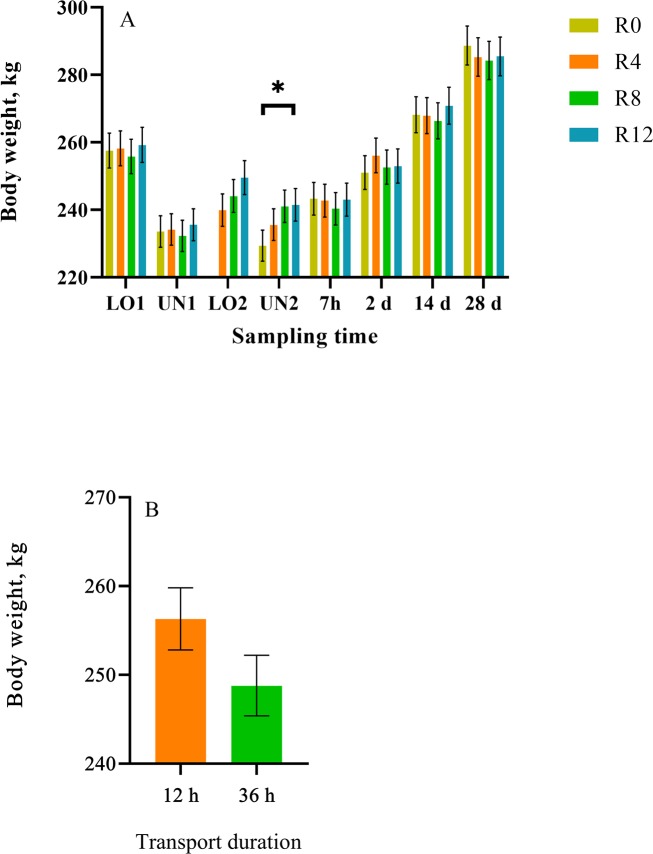
Least square means (± upper and lower limits) of body weight of conditioned black Angus and black Simmental calves.Body weight (kg) of calves receiving 0, 4, 8 and 12 h of rest and (B) body weight (kg) of calves transported for 12 and 36 h. a-bLeast square means with differing superscripts differ (p ≤ 0.05). *p ≤ 0.05.